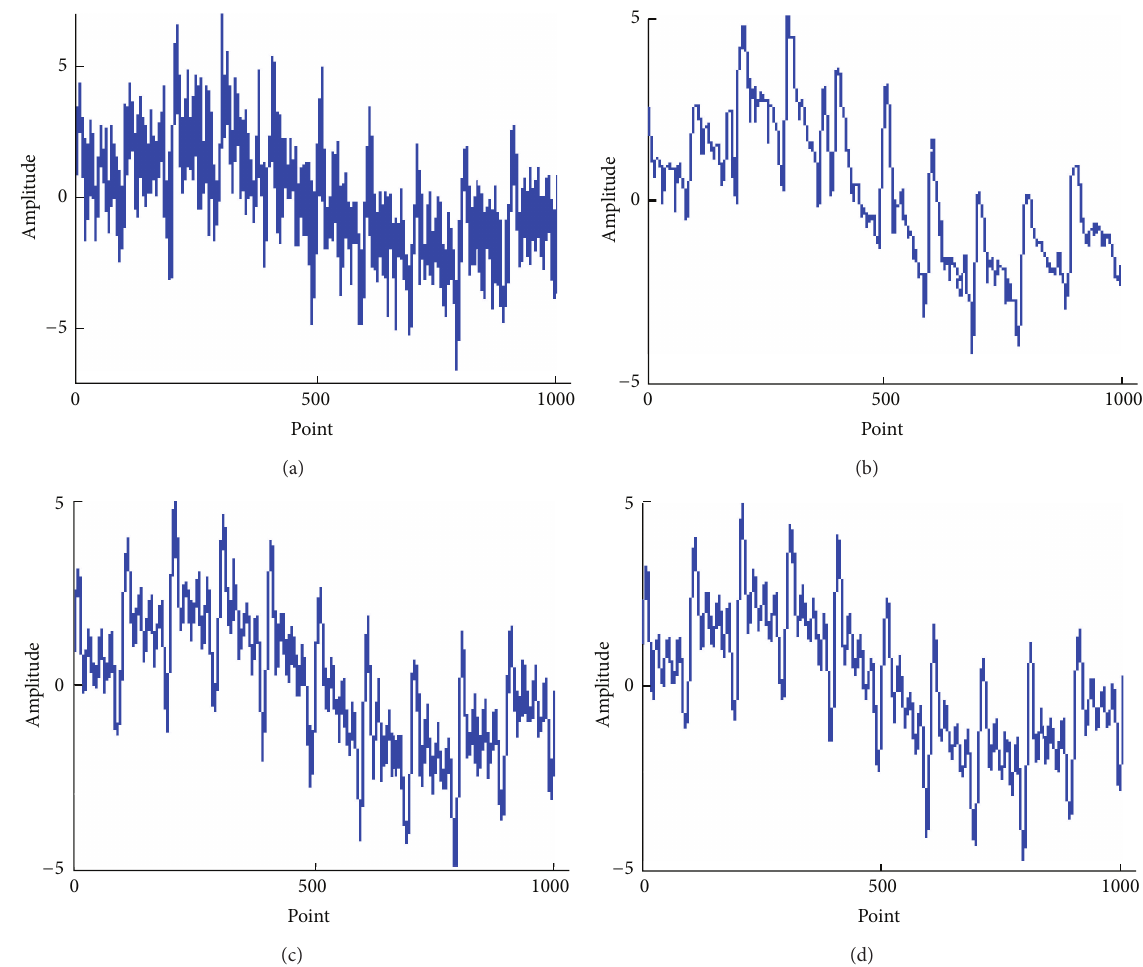
Figure 1: Comparison of denoised results obtained by optimal filter, morphological filter of flat SE, and the wavelet of Morlet, for the impulse signal: (a) the original signal, (b) the wavelet of Morlet, (c) the morphological filter of flat SE, and (d) the optimized morphological